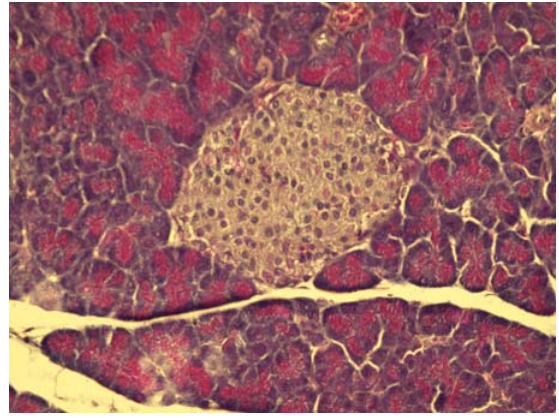
Figure 2. Microphotograph of the pancreas of control mice (HE 400×). Pancreatic islets with distinctly-outlined cell borders (physiological findings).